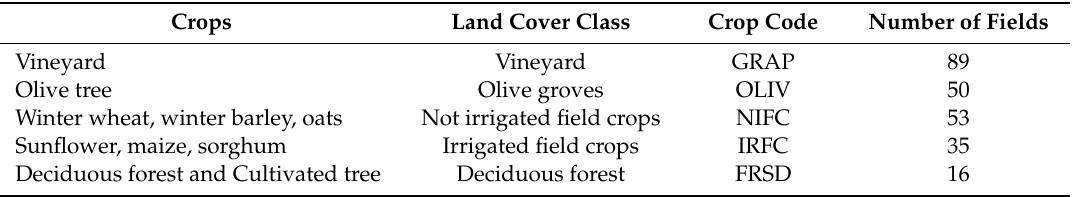
Table 1. Number of monitored fields for land cover class: broad-leaved forest (FRSD); irrigated field crops (IRFC); unirrigated field crops (NIFC); olive groves (OLIV); vineyards (VINE). Crops